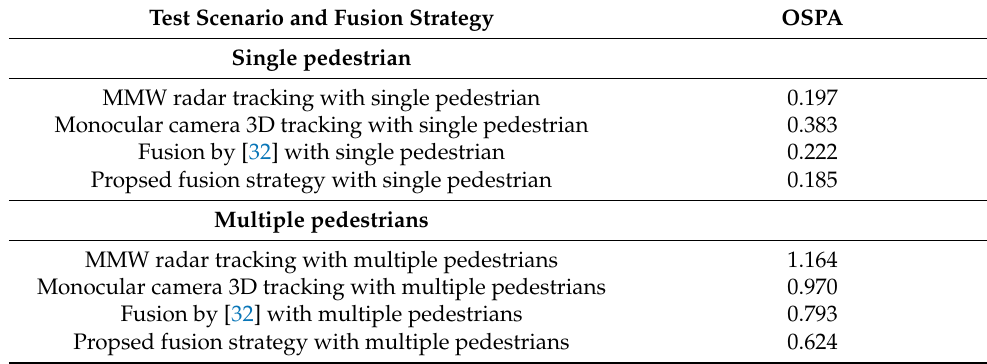
Table 3. The OSPA tracking performance of the proposed tracking method in different test scenarios.